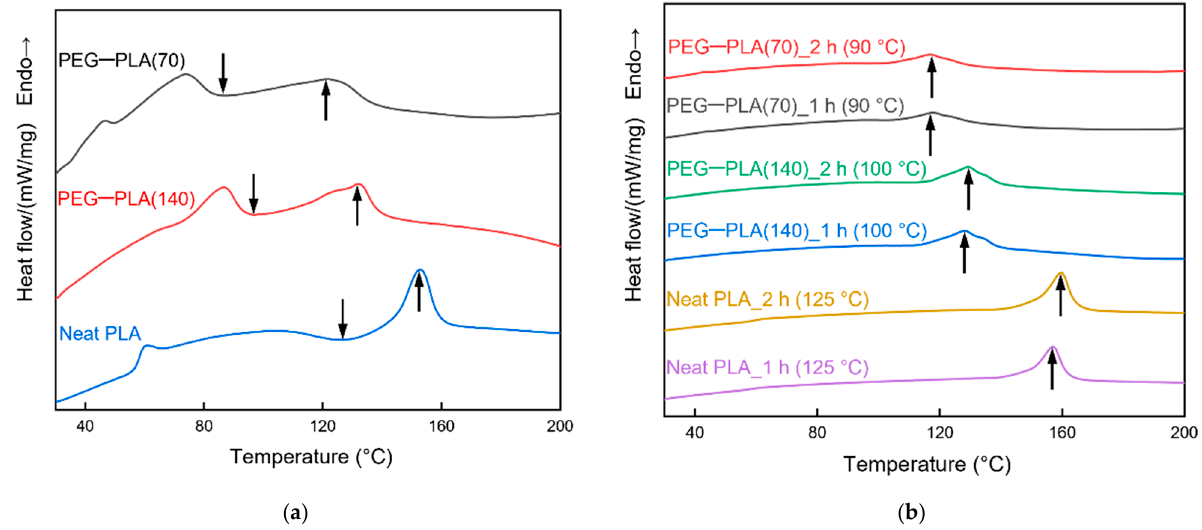
Figure 10. DSC analysis of the ( a ) untreated and ( b ) heat-treated hydrophobic materials.